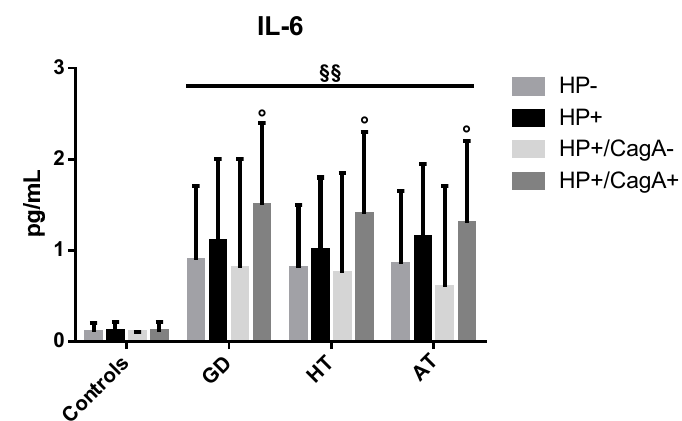
Figure 3. Median values (IQR) of IL-6 in patients and controls according to the overall H. pylori and CagA infectious status. ° p < 0.05: HP+/CagA+ vs. HP+/CagA − patients, §§ p < 0.01 AITDs vs. no-AITD.